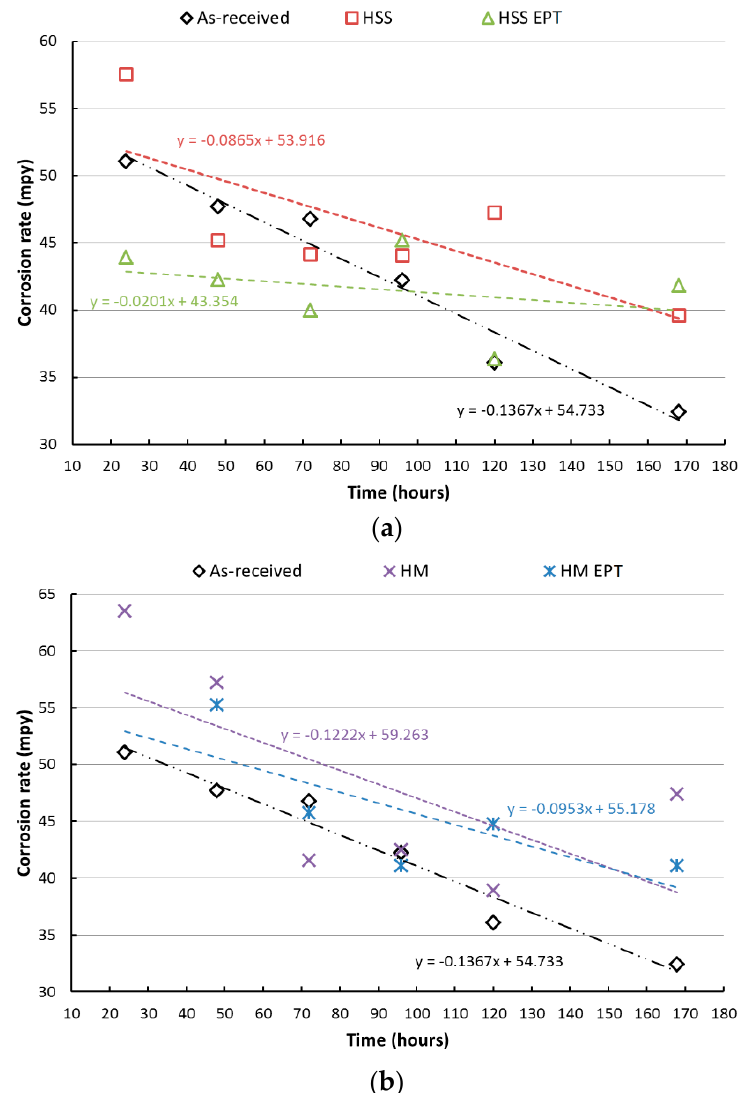
Figure 4. Corrosion rates after the salt spray test. ( a ) HSS tool, ( b ) HM tool with and without electropulsing treatment.